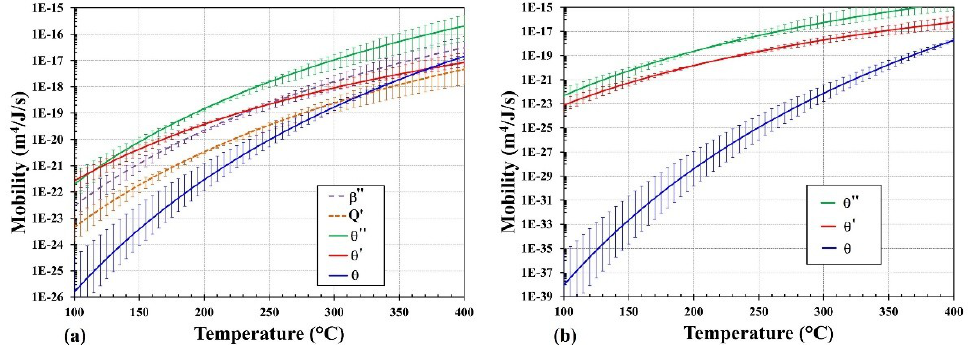
Figure 9. Diagram showing temperature dependency of the interfacial mobility of precipitates ( a ) in the studied AlSi7Cu3.5Mg0.15 (Mn, Zr, V) alloys, ( b ) in the binary Al-3.5 wt%Cu from the previous study (data from [22]).